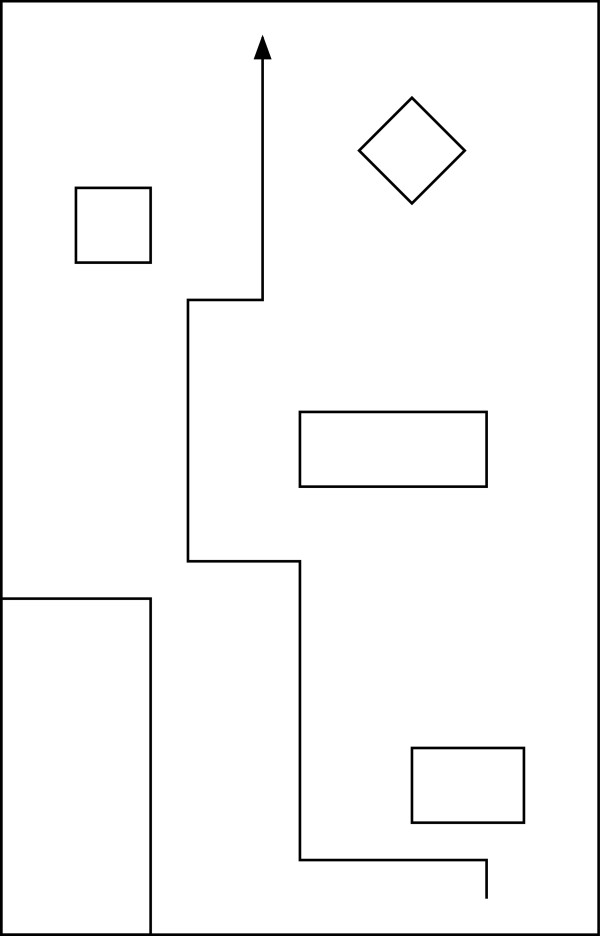
Obstacle Course 2.